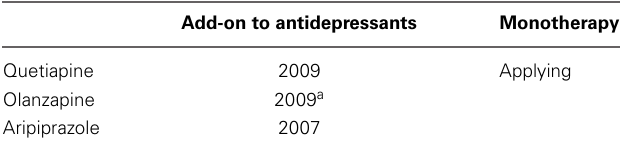
Table 2 | Year of approval for major depression. FIGURE 10 | Advantage of atypical antipsychotic drugs (AAPDs) for